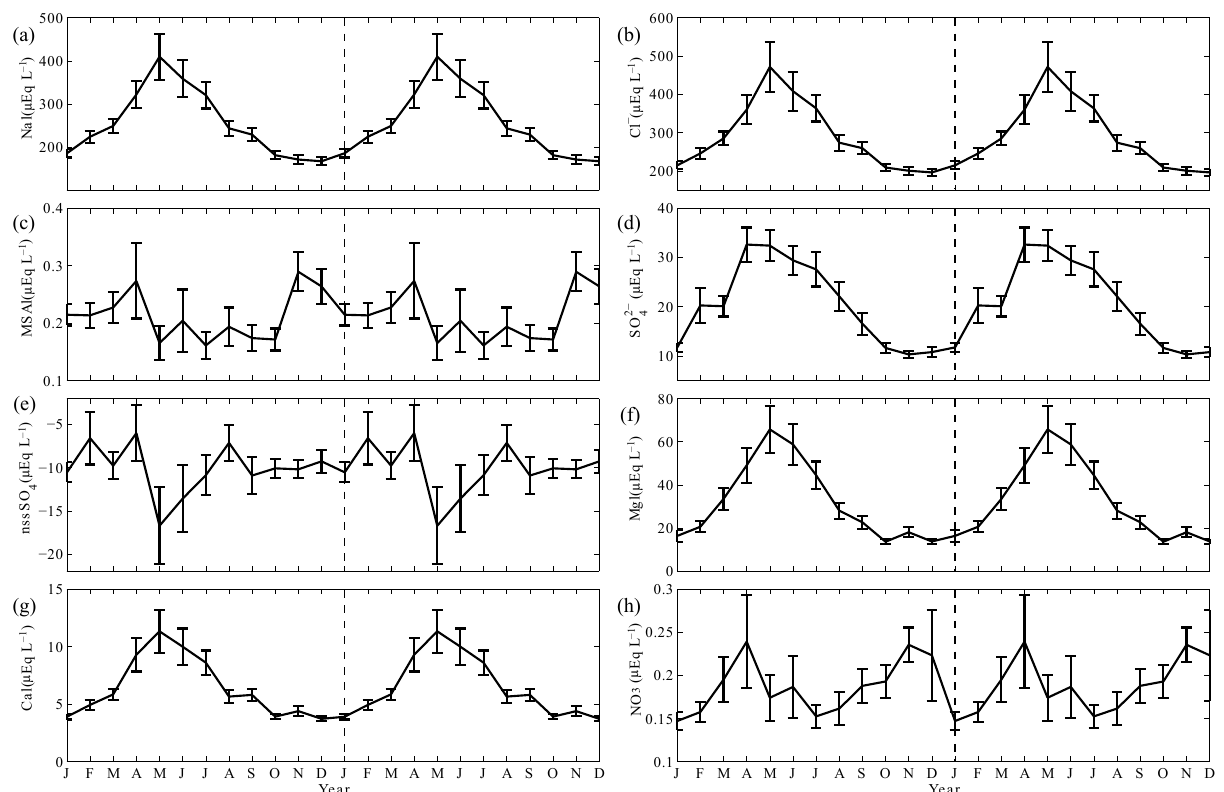
− , (e) nssSO 2 − , (f) Mg + , (g) Ca + , and (h) NO − 4 4